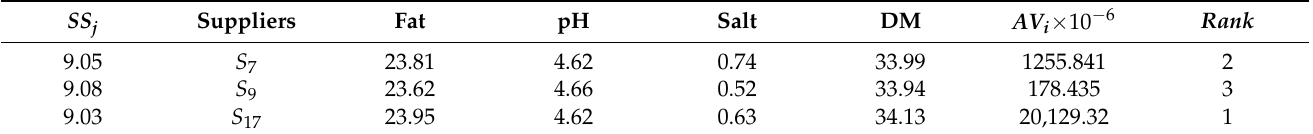
Table 14. Ranking of the cheese suppliers.